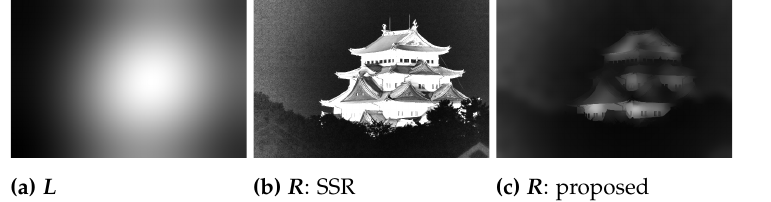
Figure 3. Luminance L and reflectance R for each method: L is shared for each method, and the output is normalized for visibility. The proposed reflectance is